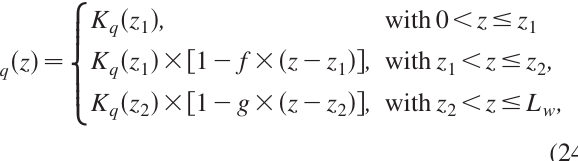
FIG. 6. GENESIS single-frequency simulations for the evolution of the radiation power, on-axis j a 200-m, hard x-ray, tapered FEL with constant r algorithm (blue lines) and multidimensional optimization (green